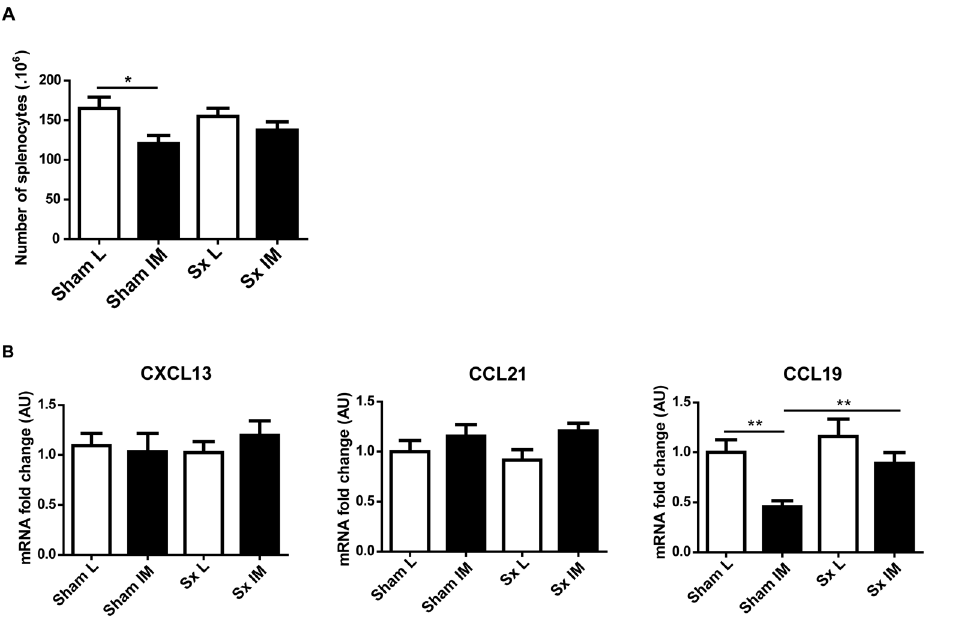
Figure 5. Spleen denervation prior to intestinal manipulation partially restores normal cell trafficking in the spleen. (A). Spleen denervation (Sx) partially prevents the decrease in the number of splenocytes 24 h after IM. (B) and the decrease in mRNA levels of CCL19. CXCL13 and CCL21 in the spleen were unaffected by the surgical intervention. Data shown are mean 6 SEM of 3 independent experiments (n=9–12 animals per group). *p , 0.05; **p , 0.01 (Two-way ANOVA).